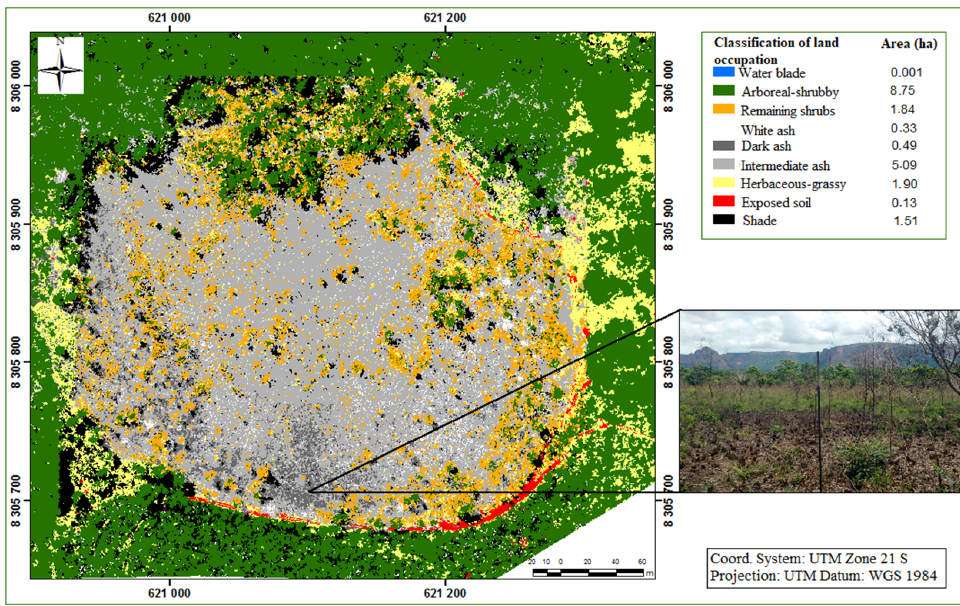
Figure 5. OBIA classification of the orthomosaic image of 8 June 2018—‘post–burning’.